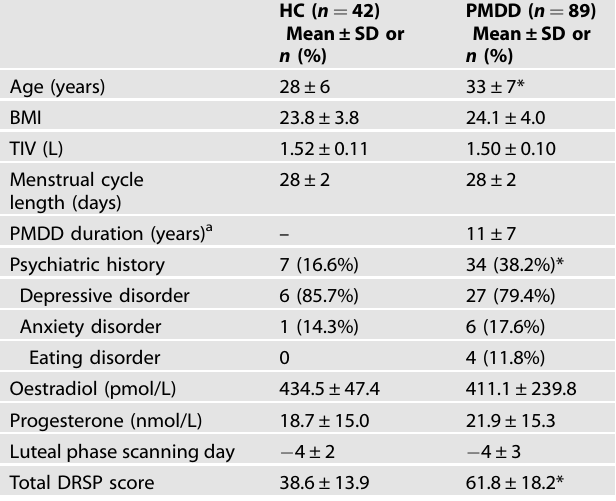
Table 1. Participant